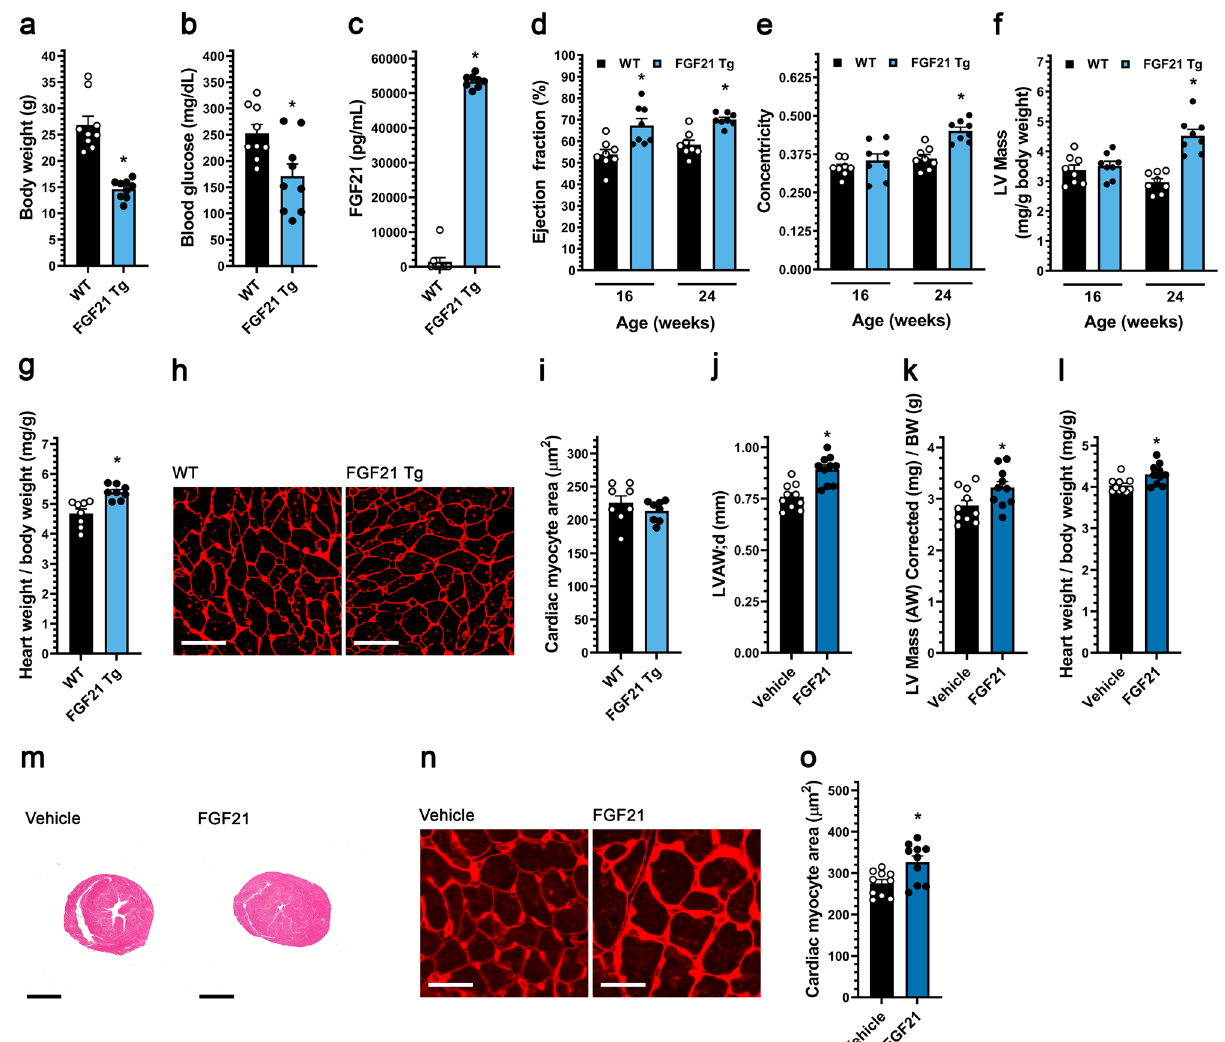
Figure 1. Systemic FGF21 elevation in mice induces concentric cardiac hypertrophy. ( a – i ) Analysis of FGF21 transgenic (Tg) mice and wild-type littermates at 24 weeks of age unless otherwise indicated. ( a ) Body weight, ( b ) blood glucose levels, and ( c ) serum FGF21 levels. ( d ) Ejection fraction, ( e ) concentricity [relative wall thickness = (LVAW;d + LVPW;d)/LVID;d], and ( f ) left ventricular (LV) mass, as determined by echocardiography at 16 and 24 weeks of age. ( g ) Heart weight/body weight ratio, ( h , i ) wheat germ agglutinin staining of LV tissue (scale bar = 25 µm) and cardiac myocyte cross-section area. ( j – o ) Wildtype mice were injected i.v. with FGF21 or vehicle for five consecutive days before analysis on the 6th day. ( j ) LV anterior wall thickness (diastole), and ( k ) LV mass/body weight ratio, as determined by echocardiography. ( l ) Gravimetric heart weight/body weight ratio. ( m ) Hematoxylin and eosin-stained transverse heart sections (scale bar = 2 mm). ( n , o ) Wheat germ agglutinin staining of LV tissue (scale bar = 25 µm) and cardiac myocyte cross-section area. Statistical significance was determined by 2-way ANOVA with post-hoc testing with Sidak’s multiple comparisons test ( d – f ), or by two-tailed t-test. All values are expressed as mean ± SEM. ( a , b ) N = 9; ( c ) N = 8–9; ( d – f ) N = 8, *p ≤ 0.05 vs. WT of same age; ( g , i ) N = 8, *p ≤ 0.05 vs. WT; ( j – l , o ), N = 10, *p ≤ 0.05 vs. vehicle. For the complete set of echocardiography parameters see Supplementary Tables 1 and cyte width by 6%, while not affecting myocyte length, resulting in a significantly increased width:length ratio indicative of a mild “concentric” myocyte hypertrophy (Fig. 2a–d). Remarkably, addition of FGF21 to medium containing high glucose further increased myocyte growth in width without affecting myocyte length, such that ARVM cultured in FGF21 and 15.6 mM glucose were 12% wider and had a width:length ratio 10% greater than control cells. We next considered that FGF21 might drive concentric remodeling in the presence of other stress stim- uli. The α-adrenergic agonist phenylephrine induces a selective growth in width of cultured ARVM, while the β-adrenergic agonist isoproterenol induces growth in both width and length, resulting in a more symmetric ARVM hypertrophy 38 . Co-treatment with FGF21 did not significantly further increase the prominent growth in width induced by phenylephrine or isoproterenol (Fig. 2e–h). Remarkably, however, co-treatment with FGF21